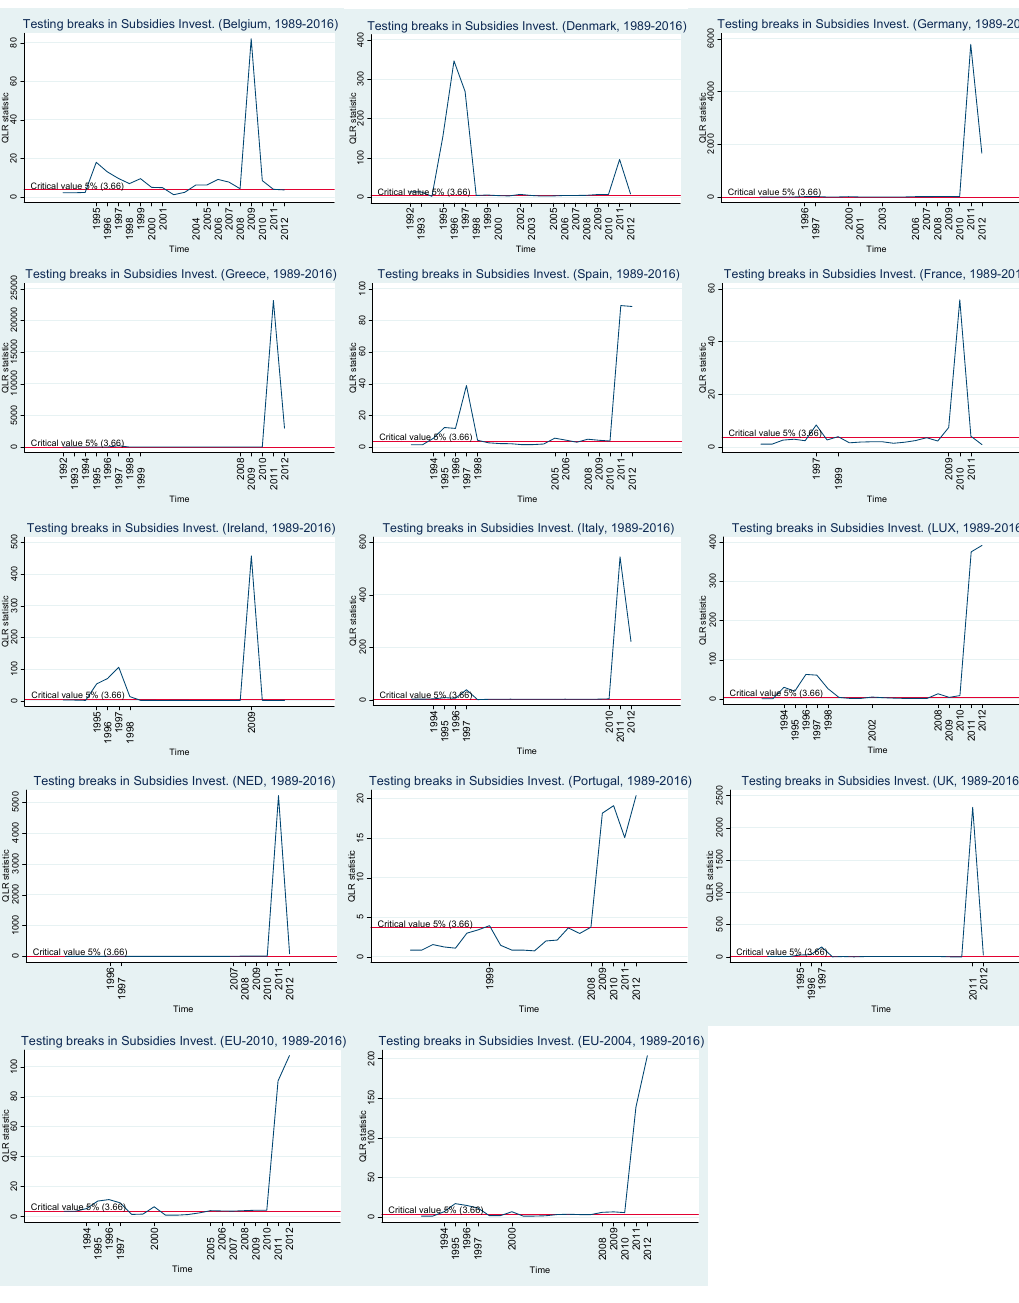
Figure 10. Testing for breaks in subsidies on investments (euros) over the European Union countries (1989–2016).